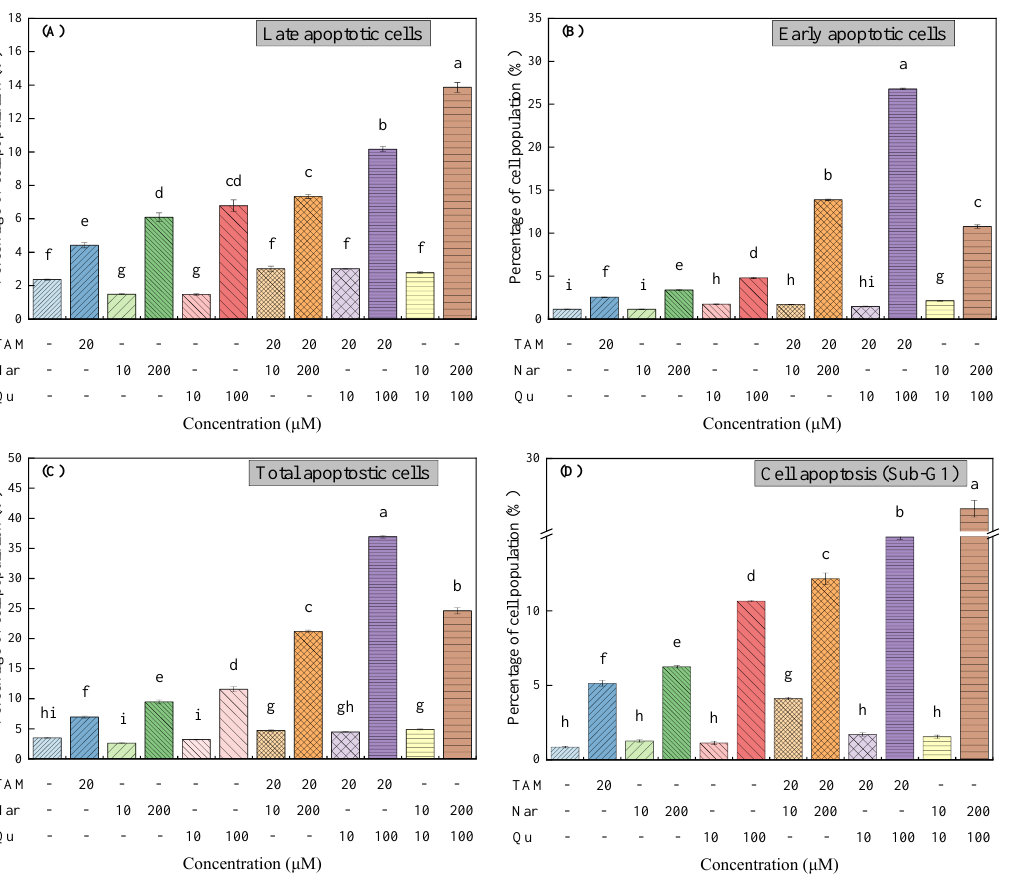
Figure 5. Tamoxifen, naringenin and quercetin regulated cell apoptosis in HepG2 cells. Cells were exposed to tamoxifen (20 μM ), naringenin (10 and 200 μM ) and quercetin (10 and 100 μM ) either alone or in combination for 24 h. ( A – C ) Percentage of cell population in the different apoptotic stages. ( D ) Sub-G1 DNA content of cells analyzed with PI staining. Results are expressed as mean ± SD of three independent experiments ( n = 3). a,b,c,d,e,f,g,h,i : Different letters indicate significant differ- ences ( p < 0.05) in cell apoptosis. DAPI staining also revealed the different degrees of cell shrinkage, nuclear con- densation or fragmentation after the cells were exposed to tamoxifen, naringenin and quercetin (Figure 6). Specifically, tamoxifen-induced apoptosis or damage was attenu- ated in the presence of 10 μM naringenin or quercetin but was increased in the presence of naringenin (200 μM) or quercetin (100 μM). Therefore, the cytotoxic effects of tamoxi- fen or higher concentrations of naringenin and quercetin on HepG2 cells were closely associated with the induction of cell apoptosis and even necrosis. Particularly, higher concentrations of naringenin and quercetin combined with tamoxifen synergistically induced cell apoptosis, but lower concentrations of them suppressed the tamoxi- fen-induced apoptosis. These results are in accordance with the proliferative or apoptotic effects detected by the CCK-8 and RTCA assays.